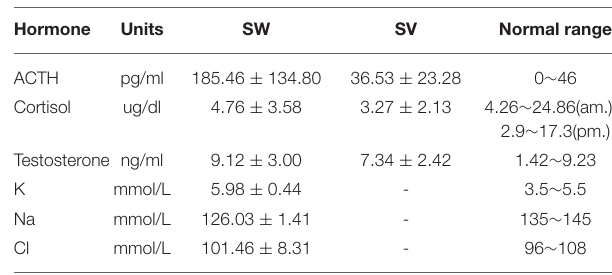
TABLE 3 | Laboratory findings for the 17-OHD patients at